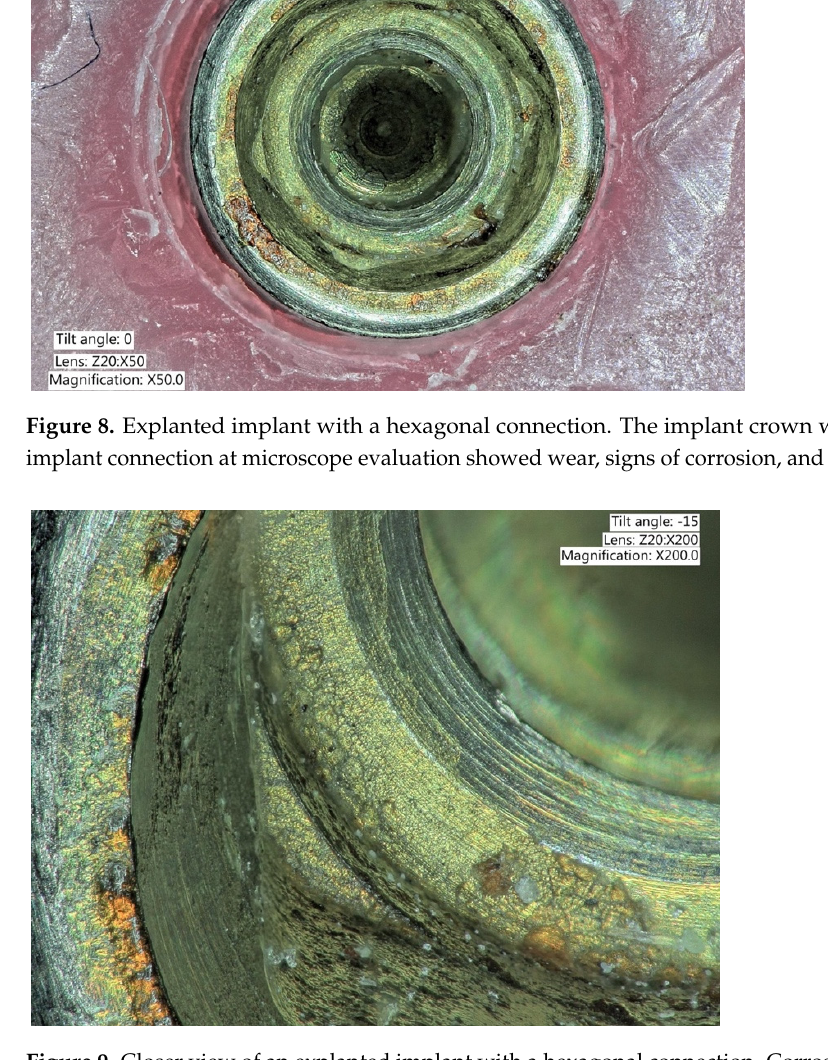
Figure 9. Closer view of an explanted implant with a hexagonal connection. Corrosion, delamination, and abrasions of the connection surface can be appreciated.